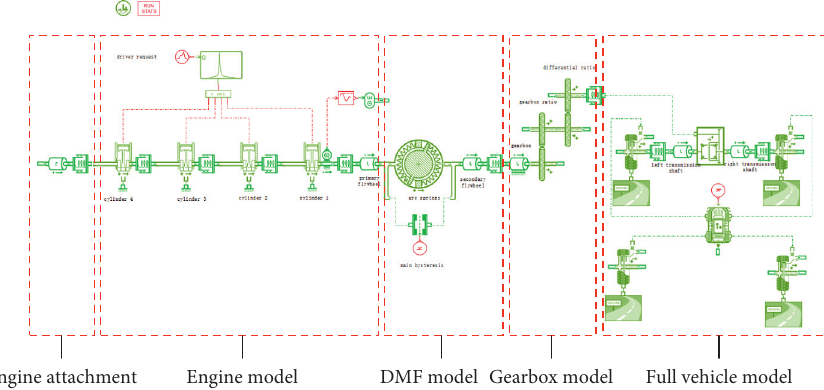
Figure 7: Initial model.